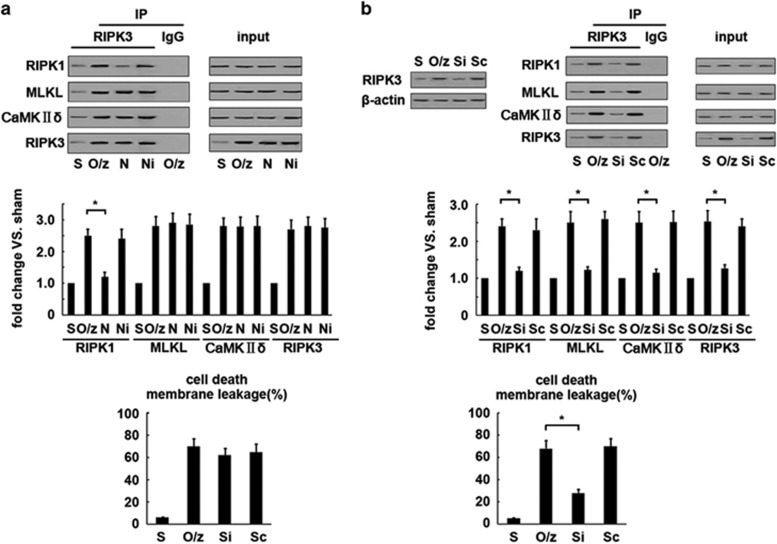
Downregulation of the RIPK3-MLKL interaction or the RIPK3-CaMKIIδ interaction attenuates OPCs death after OGD/zVAD. (a) Immunoprecipitation 12 h after OGD shows that the RIPK3–RIPK1 interaction was decreased after Nec-1 treatment, whereas the RIPK3-MLKL and RIPK3-CaMKIIδ interactions were not decreased. Cell death, as determined by measuring released protease activity in the culture medium 24 h after OGD, was not affected after Nec-1 treatment. Data are presented as means±S.E.M. from three independent experiments. N=6 for each group in each experiment. S: sham; O/z: OGD/zVAD; N: Nec-1; Ni: Nec-1 inhibitor. (b) Western blotting indicates that RIPK3 siRNA treatment significantly reduced RIPK3 expression 12 h after OGD. Immunoprecipitation assays showed that the RIPK3-MLKL and RIPK3-CaMKIIδ interactions were decreased 12 h after OGD following the inhibition of RIPK3 via RIPK3 siRNA treatment. Cell death, as determined by measuring the released protease activity in the culture medium, was significantly decreased 24 h after OGD following RIPK3 inhibition. Data are presented as means±S.E.M. from three independent experiments. N=6 for each group in each experiment (P<0.05, comparing the siRNA group with the OGD/zVAD group). S: sham; O/z: OGD/zVAD; Si: RIPK3 siRNA; Sc: RIPK3 siRNA scramble